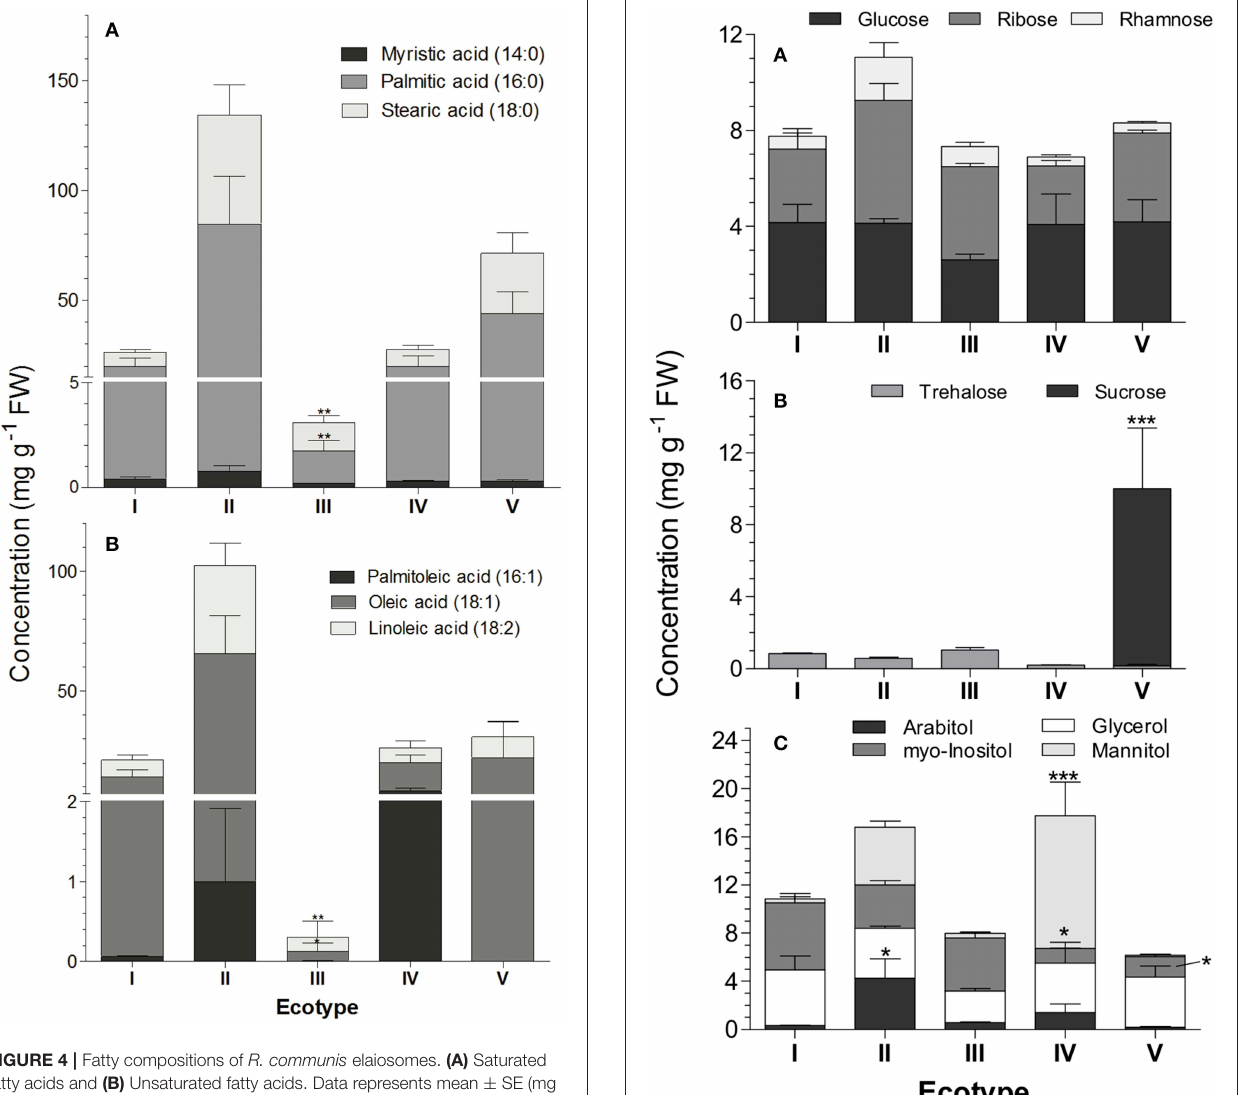
ants over longer distances, with those of seeds and